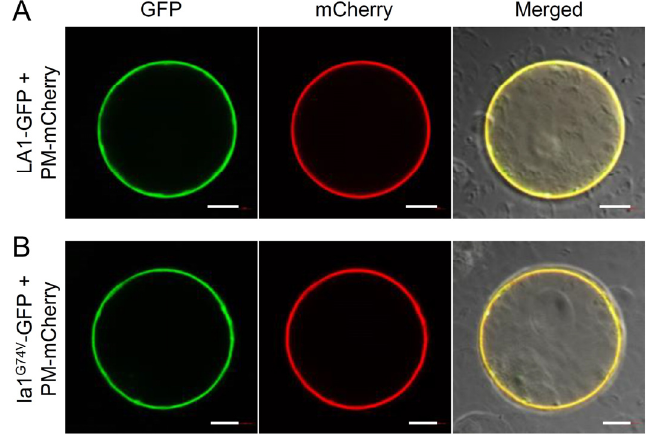
Figure 4. Plasma-membrane localization of LA1 and la1 G74V . The LA1-GFP ( A ) and la1 G74V -GFP ( B ) constructs were co-expressed with the plasma-membrane-localized PM-mCherry construct in rice protoplasts, respectively. Scale bars, 10 μ m.